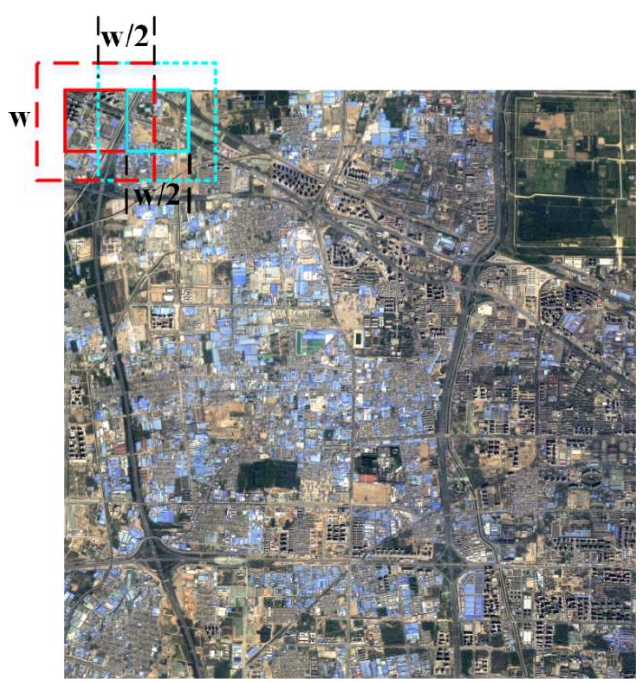
Figure 11. Sliding window image prediction. W is the window size.